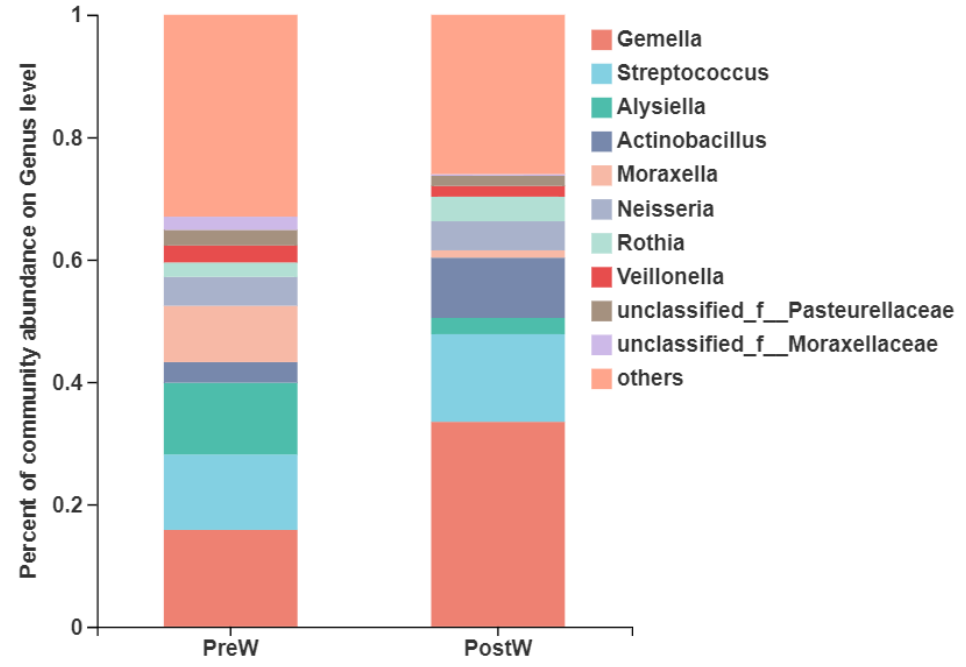
Figure 5. Composition of the predominant oral bacteria at genus level between preweaning and postweaning donkeys (abundance of the genera was expressed as %). PreW, preweaning group; PostW, postweaning group.